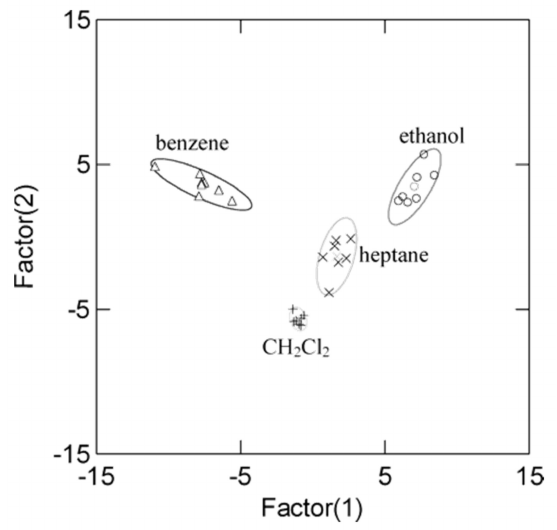
Figure 5. Linear discriminant analysis (LDA) canonical scores plot of four organic vapors with different concentrations tested with an IL-coated QCM sensor array. Seven replicate measurements were taken for each vapor. Figure is reproduced from